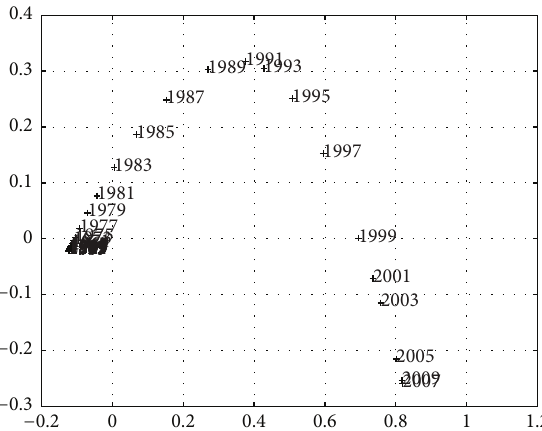
Figure 7: Two-dimensional MDS map of the Portuguese economic evolution, in the perspective of the Euclidean distance 𝑟 𝐸 , 𝑇 = 1865 – 2010 , ℎ = 2 years.